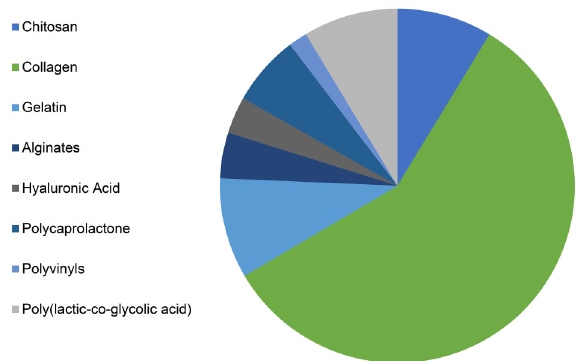
Figure 3. Graph showing polymer distribution in publications retrieved from a search in the PubMed database with the terms: